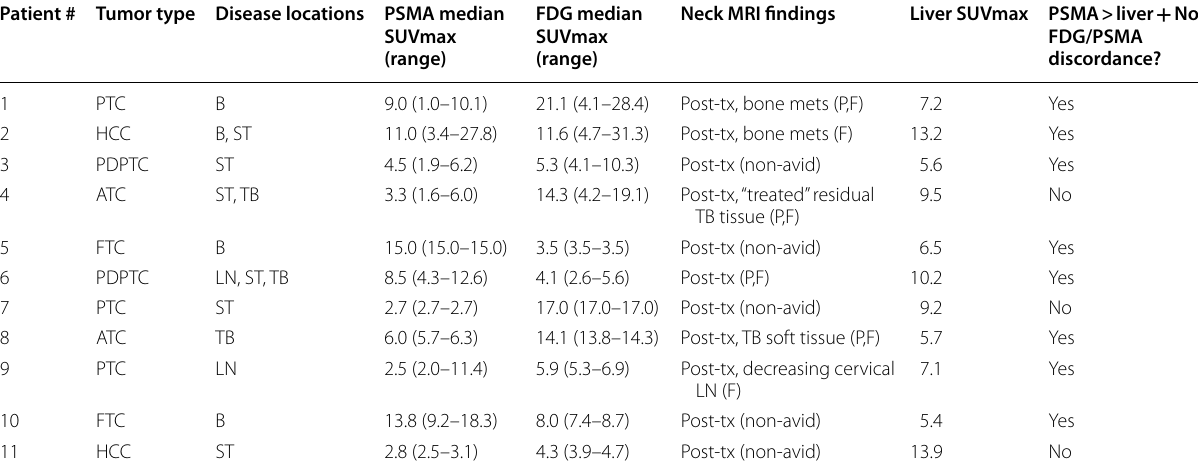
Table 2 Metastatic disease locations and median lesion SUVmax for each patient